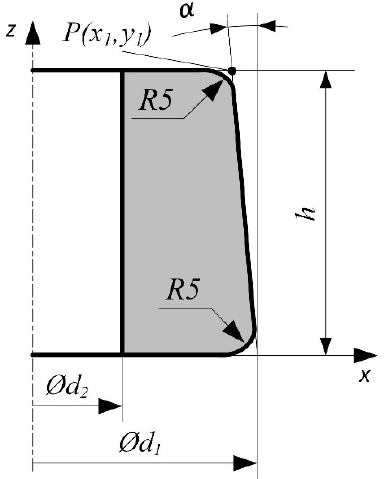
Figure 1. The axisymmetric cross-section of the investigated rubber bumper.